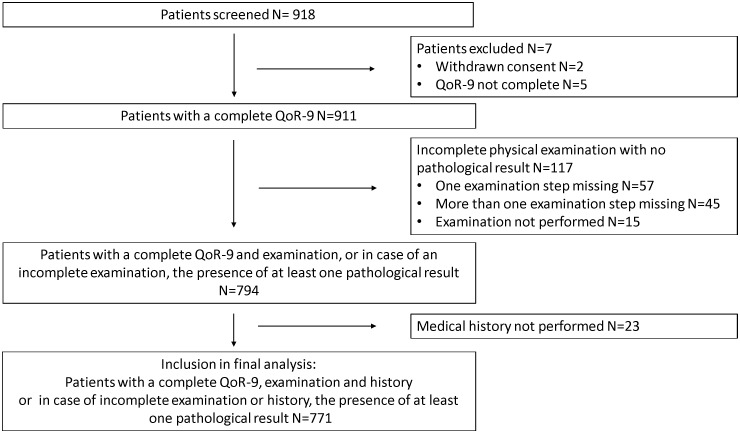
Consort diagram.